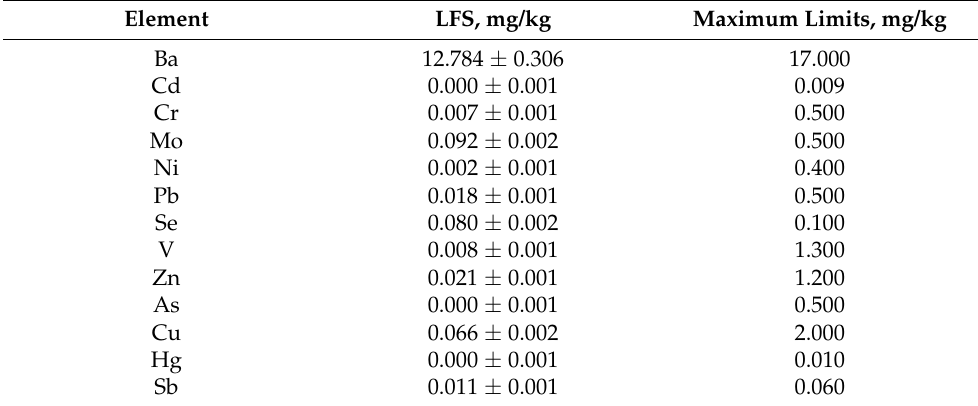
Table 4. Concentration of chemical elements in the leaching of ladle furnace